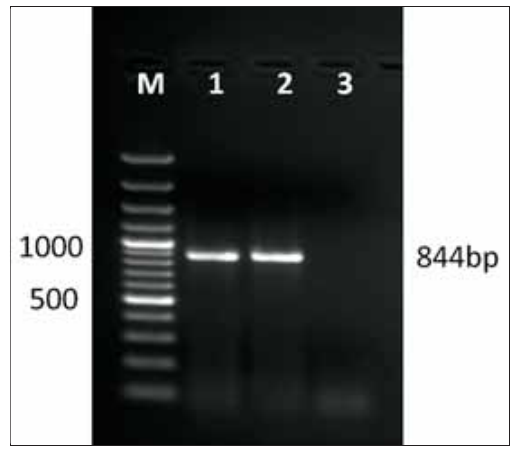
Figure-2: Electrophoresis of amplificated DNA of nad-bhbd gene of Clostridium chauvoei ; M-DNA ladder, 1 and 2- nad- bhbd gene, 3-Negative control.